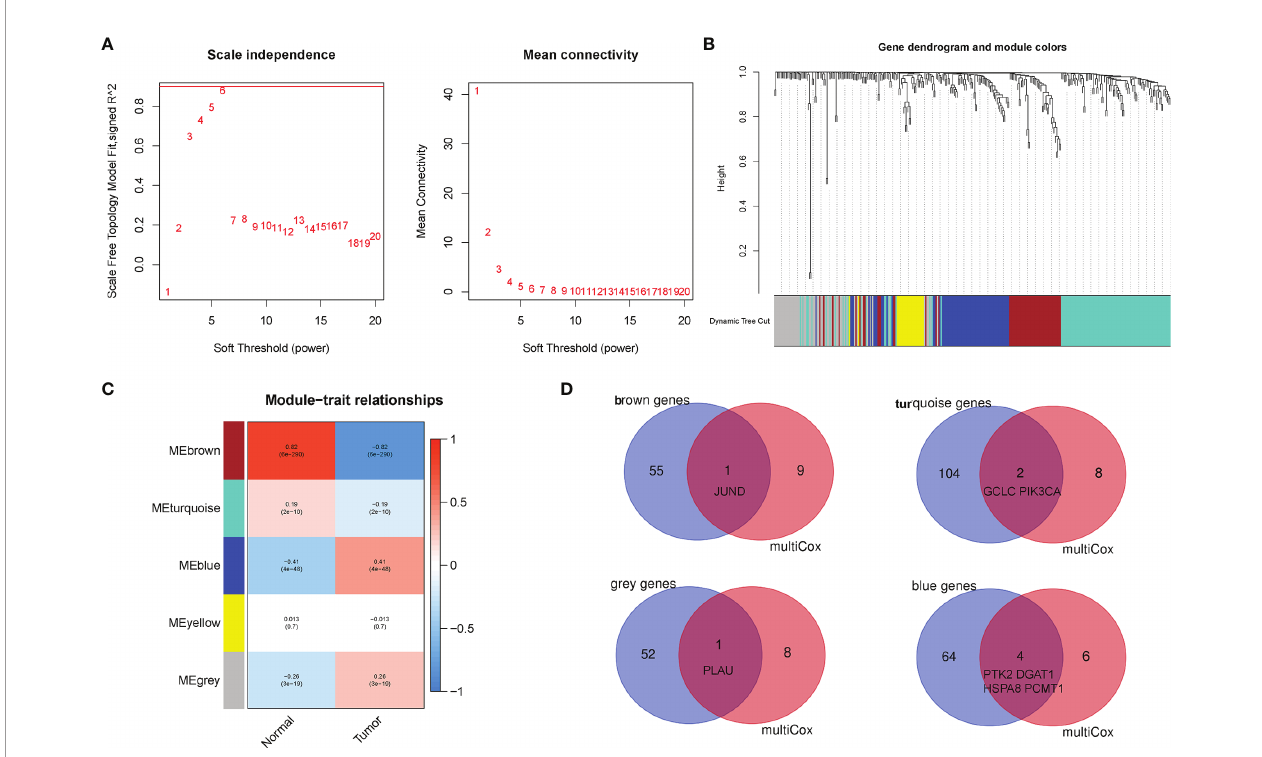
FIGURE 5 | Establishment of weighted co-expression network and identi fi cation of signi fi cant modules with breast cancer (BC) prognosis. (A) The scale-free fi t index for various soft-thresholding powers ( b ). The power of b = 6 was set as the soft-thresholding parameter to meet the scale-free topology. (B) Dendrogram of all aging-related genes (AGs) clustered based on a dissimilarity measure. (C) Identifying co-expression modules associated with the BC progression. The red module represented a positive correlation with clinical features, while the blue module represented a negative correlation with clinical features. (D) The Venn diagram revealed that eight AGs among the aging-related risk model were identi fi ed to be related to